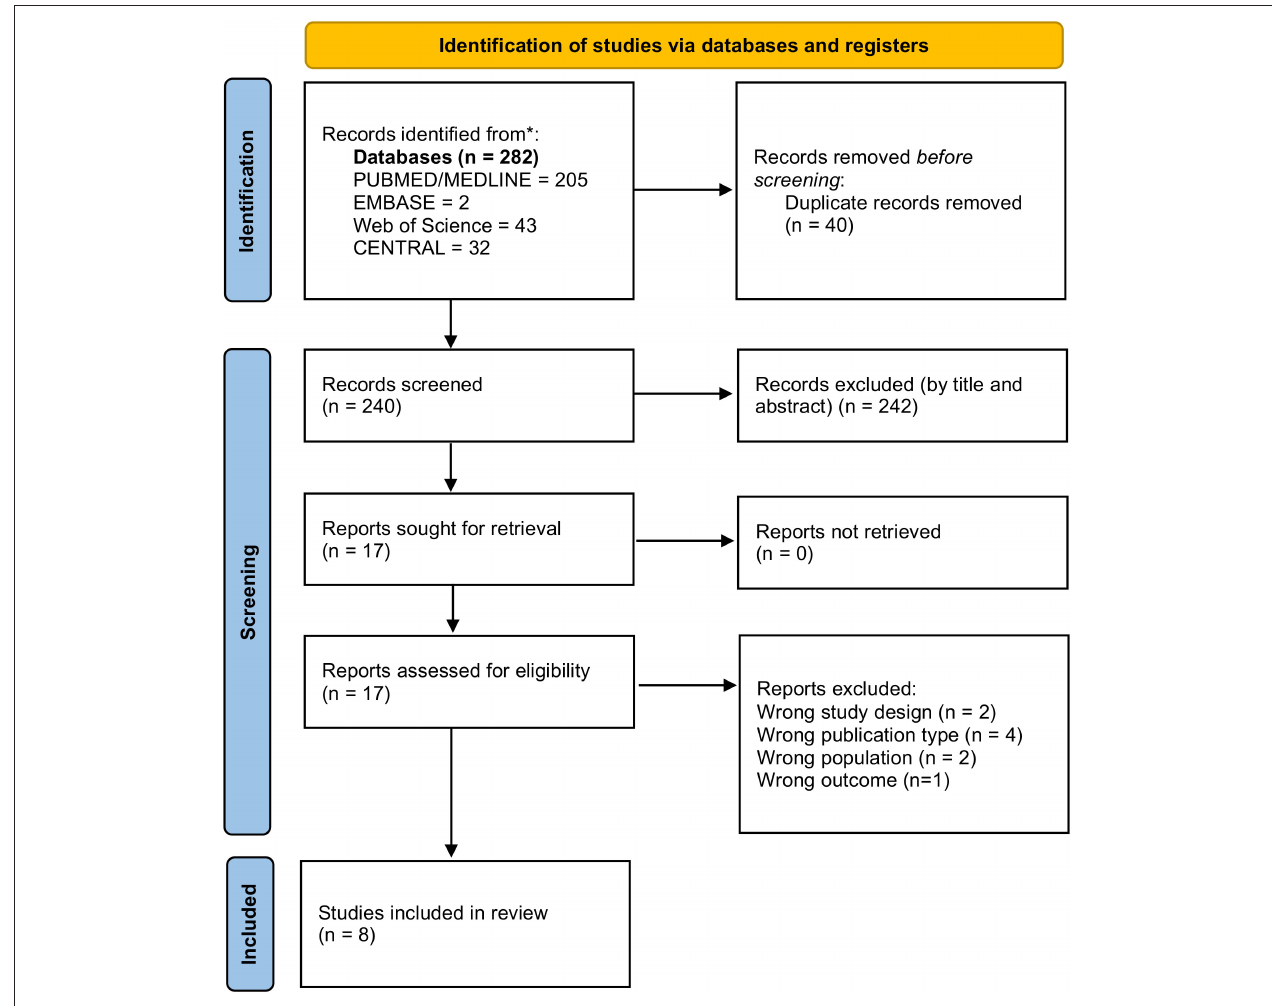
FIGURE 1 | Study selection